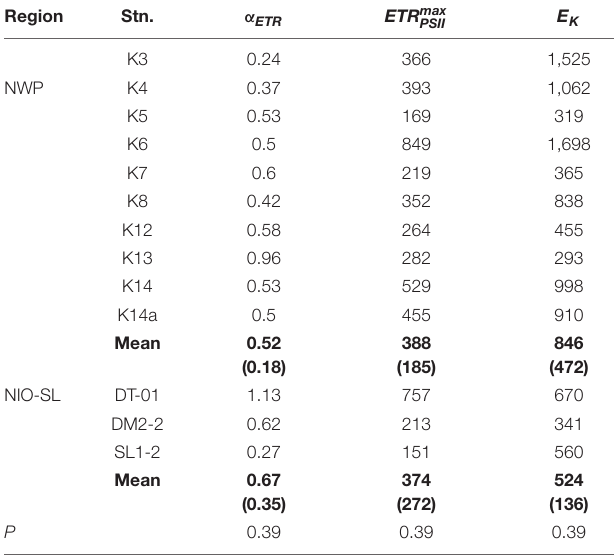
TABLE 4 | Value of α ETR [mol e − mol RCII − 1 s − 1 ( µ mol quanta m − 2 s − 1 ) − 1